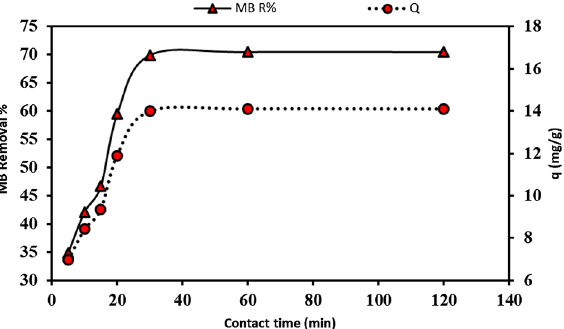
Figure 5. Contact time vis MB biosorption by the biomass of P. alcaliphila NEWG-2